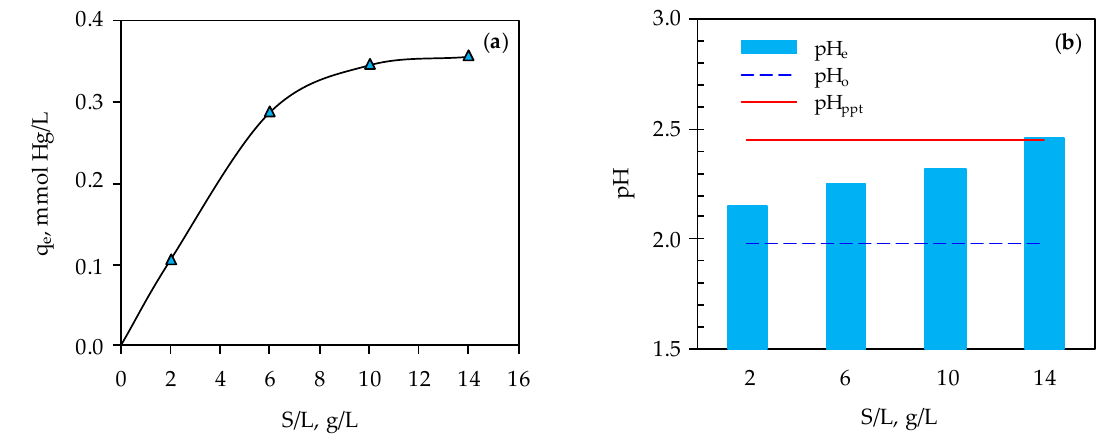
Figure 12. ( a ) The effect of the solid/liquid (S/L) ratio on the amount of Hg(II) sorbed onto SZ. ( b ) Comparison of pH e and pH ppt with pH o in relation to the S/L ratio.